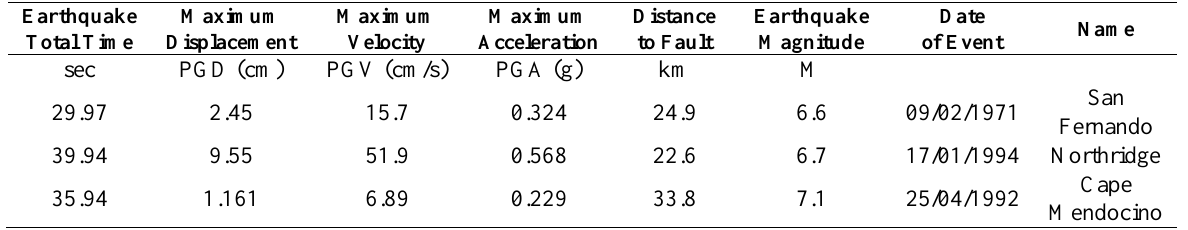
Table 2. Characteristics of the acceleration time history